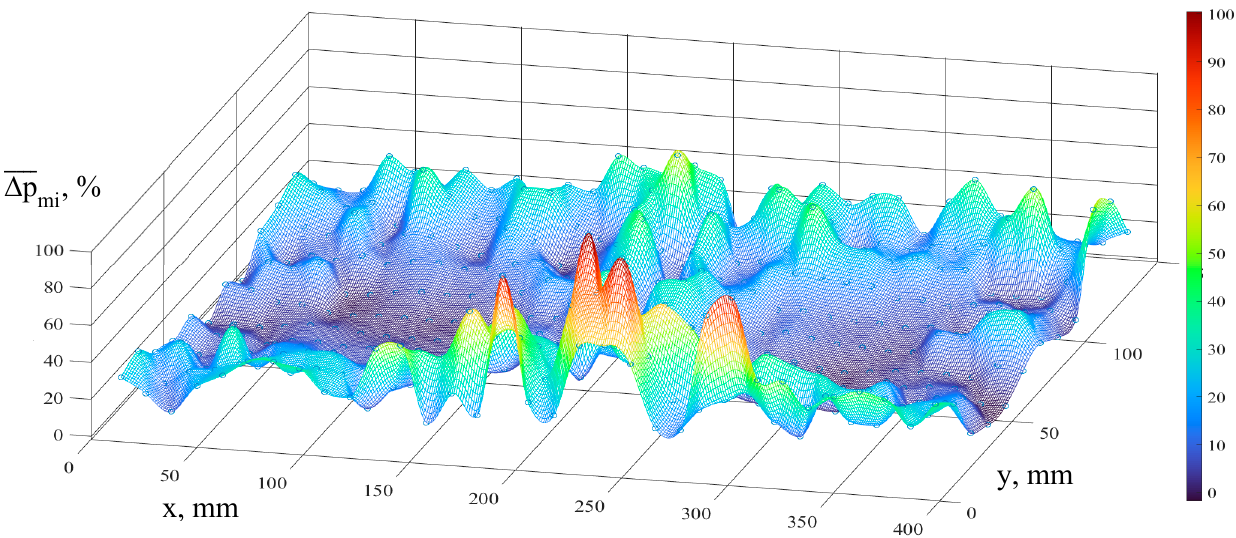
Figure 7. Map of mean relative deviations ∆p(cid:3364)(cid:3364)(cid:3364)(cid:3364) (cid:2923)(cid:2919) from mean pressure values p mi at measured points.